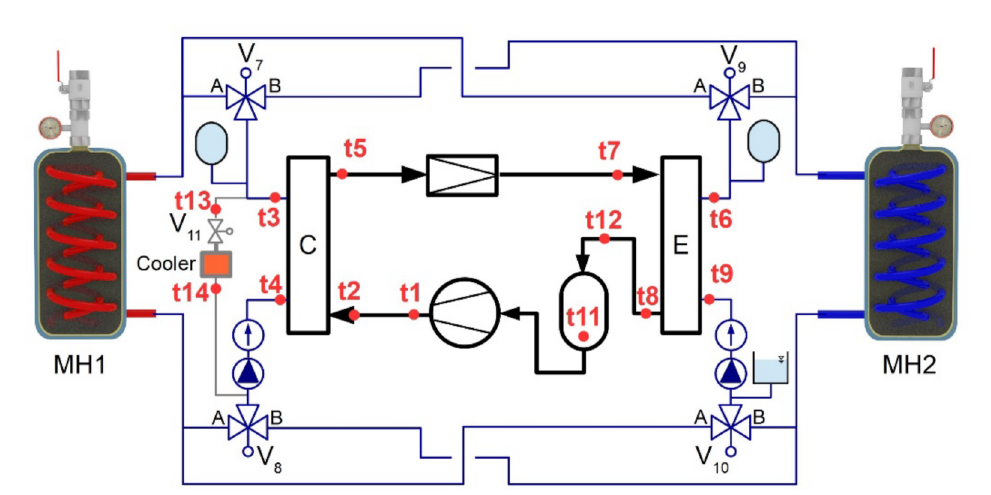
Figure 3. Diagram of a heat pump with a water circuit.